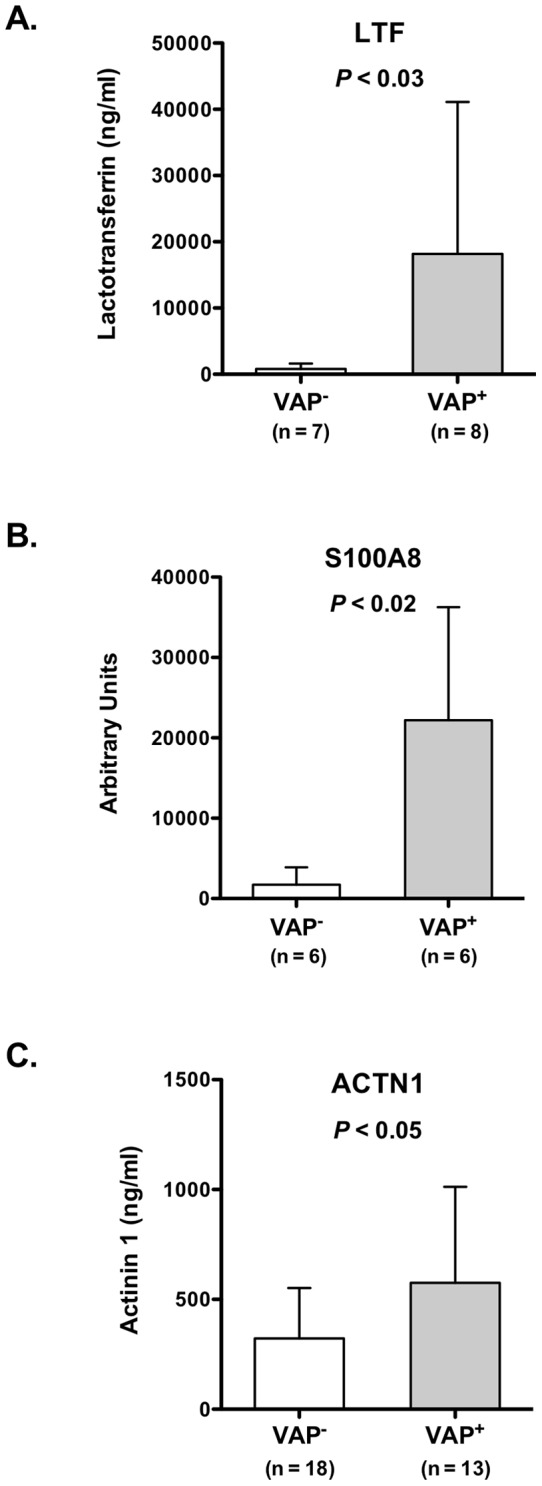
Validation of the limited proteomic classifier in an independent cohort of critically ill patients with clinical suspicion of VAP.Panel A confirms elevated levels of LTF in BALF of VAP+ patients compared to VAP– subjects using ELISA. Panel B demonstrates increased abundance of BALF S100A8 in VAP+ based on Western analysis (see also supplementary Figure S1). Panel C displays increased levels of ACTN1 in BALF of VAP+ patients compared to VAP– using ELISA.